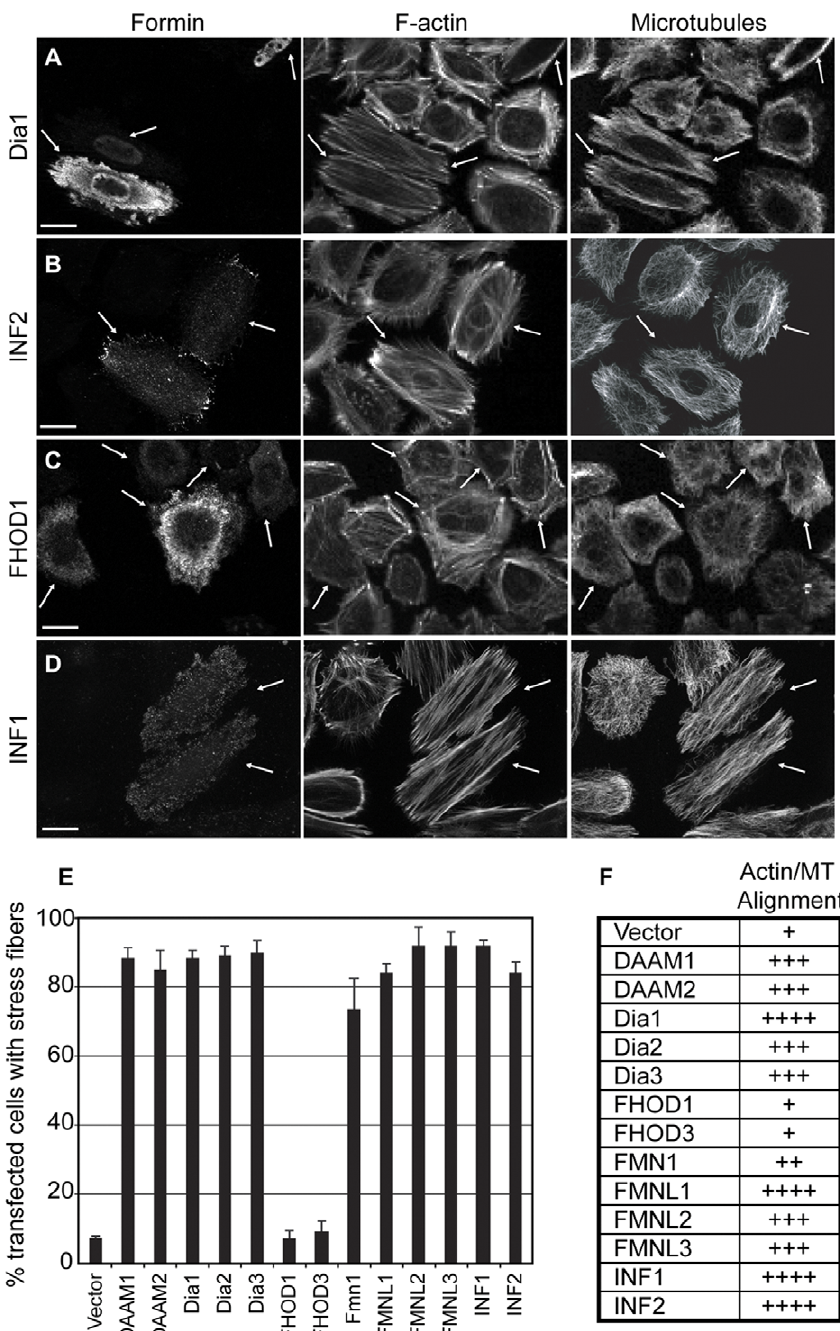
Figure 2. Induction of F-actin and microtubule alignment by expression of the formin FH1–FH2 module. FH1–FH2 containing derivatives of thirteen of the fifteen mammalian formins were over-expressed by transient transfection in HeLa cells and the effects on cellular morphology were observed by immunofluorescence. A ) Over-expression of Dia1 FH1–FH2 (left panel) induces stress fiber formation (middle panel) and their concomitant co-alignment with the microtubule network (right panel). B ) INF2 FH1–FH2 expression also induces co-alignment of stress fibers and microtubules. C ) Over-expression of FHOD1 FH1–FH2 fails to induce stress fiber formation. D ) INF1 FH1–FH2 expression induces stress fiber formation and microtubule co-alignment. E ) Quantification of stress fiber formation. The number of transfected cells with obvious increased stress fiber formation was counted. N=3, with greater than 100 cells counted per sample. Error bars represent SEM. F ) Summary of stress-fiber alignment with the microtubule network as assessed visually by immunofluorescence. doi:10.1371/journal.pone.0048041.g002 of FH1FH2-containing derivatives of either Fmn1, FHOD1 or FH2 dependent activity of the formins fall into three groups: FHOD3 had no effect on microtubule acetylation over back- strong acetylators (Dia1,2,&3, DAAM1&2, FMNL1, and INF1), ground (approximately 5% of transfected cells). Thus the FH1–